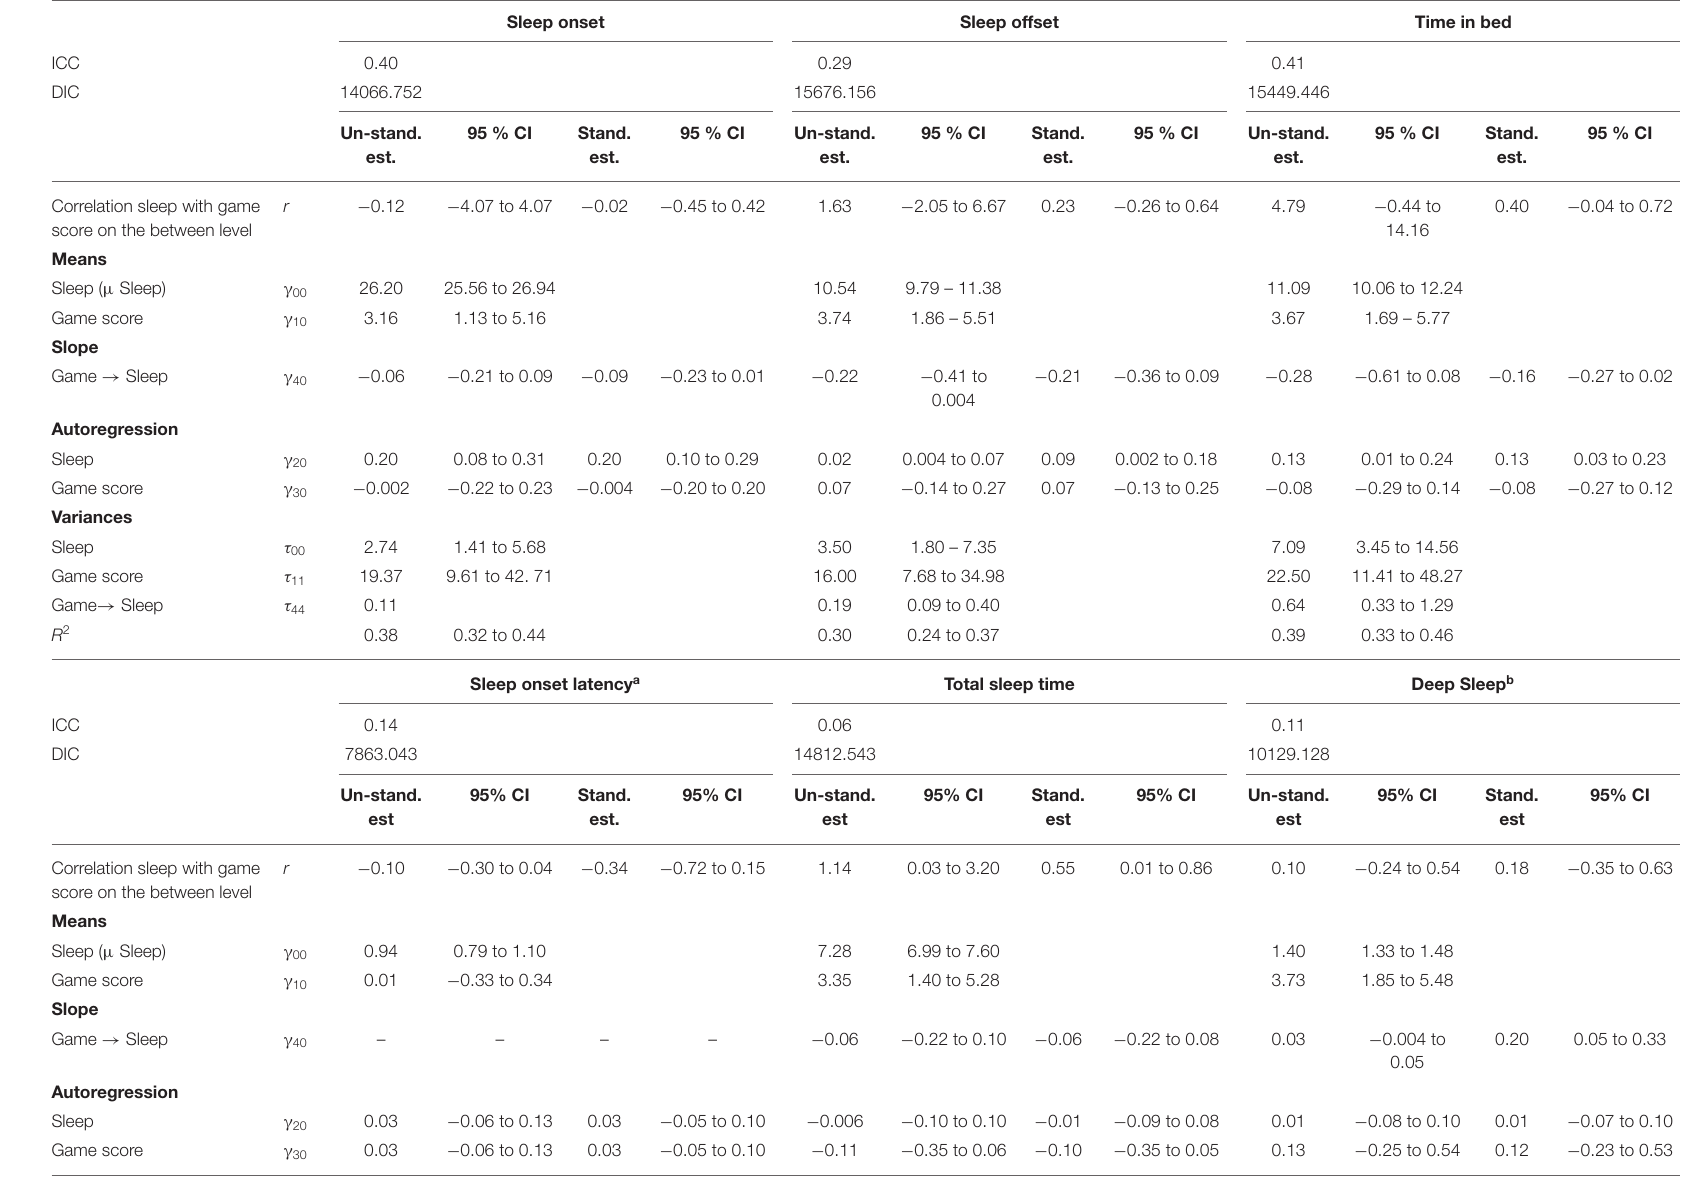
TABLE 5 | Unstandardized and standardized